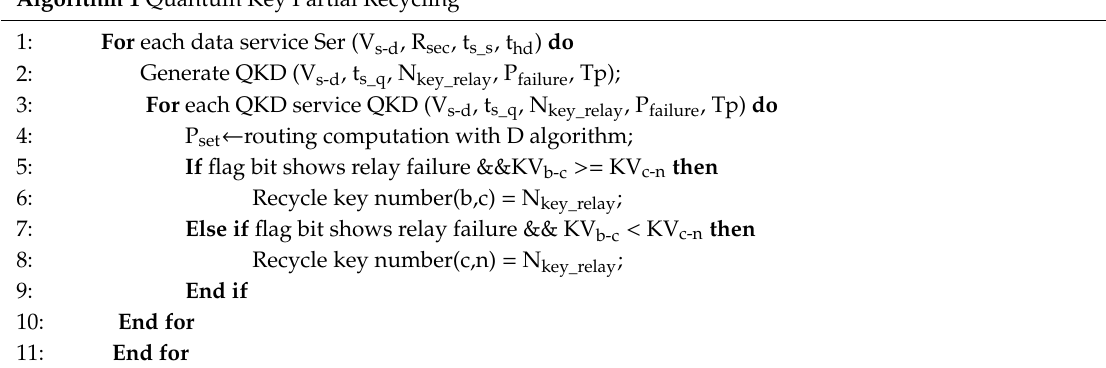
Algorithm 1 Quantum Key Partial